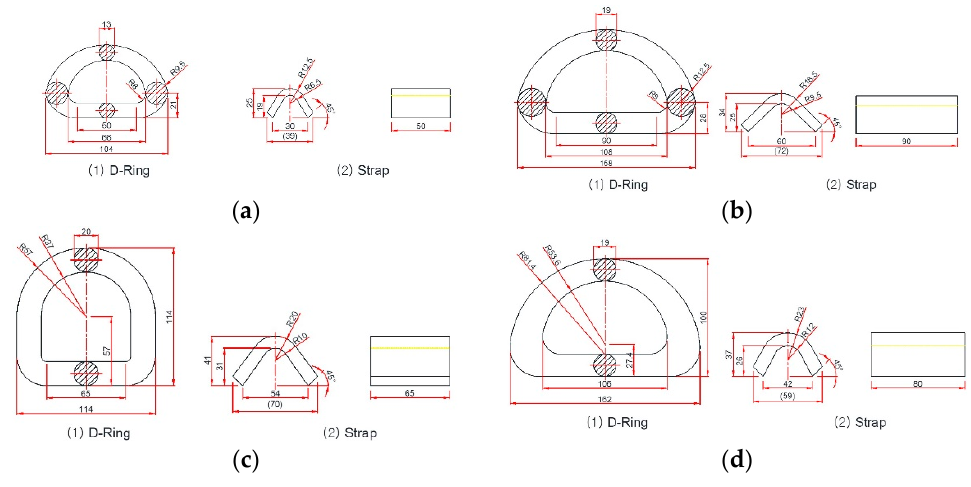
Figure 1. Four types of D-Rings (unit: mm). ( a ) Type 1 D-Ring with 3.0 ton f MBL; ( b ) Type 2 D-Ring with 20.0 ton f MBL; ( c ) Type 3 D-Ring with 20.4 ton f MBL; ( d ) Type 4 D-Ring with 25 ton f MBL.